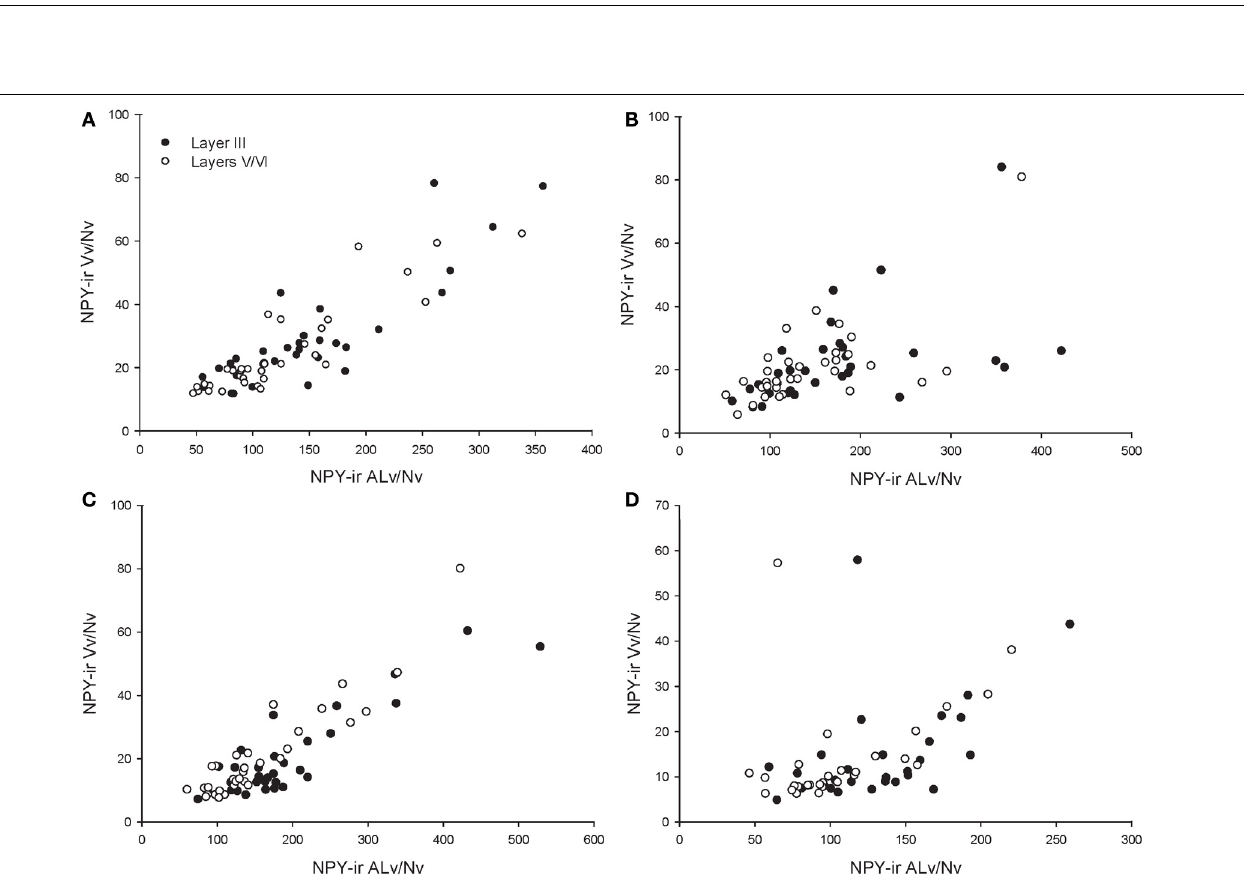
FIGURE 4 | Correlations between NPY-irALv/Nv and Vv/Nv for (A) area 10, (B) area 24, (C) area 44, and (D) area 22. The outlier in (B) and (D) is one chimpanzee male.